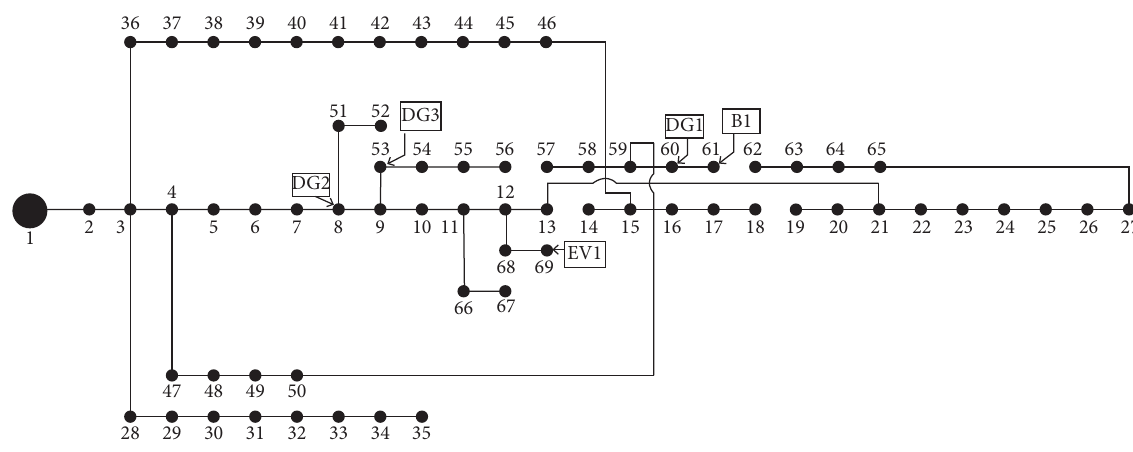
Figure 6: Topology 2 of IEEE 69 bus system. Table 1: Battery operation for scenario 1. Table 2: Battery operation for scenario